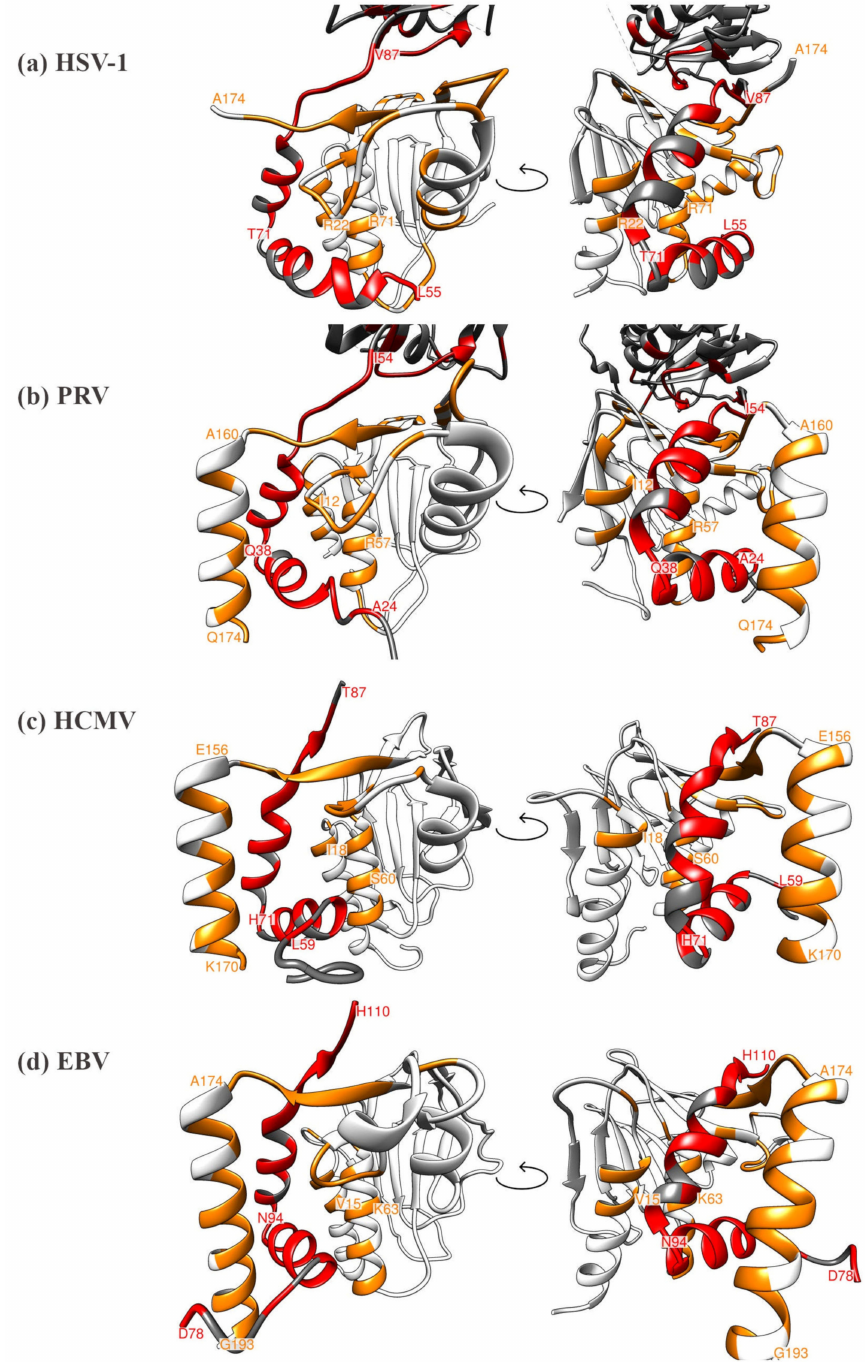
Figure 4. Comparison of the currently available four herpesviral 3D core NEC crystal structures, highlighting the heterodimeric contact interfaces, each in two di ff erent viewing angles (left and right rotated by 90 degrees). ( a ) HSV-1 core NEC, ( b ) PRV core NEC, ( c ) HCMV core NEC, ( d ) EBV core NEC. Interacting residues within the hook or groove are colored in red and orange, respectively. Distinct amino acids marking the start or end positions of structural elements are labeled as orientation